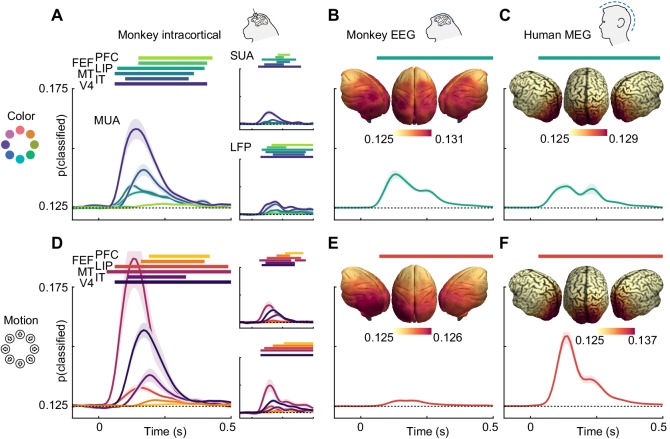
Color and motion direction information across areas and measurement scales.All panels show classifier accuracy, quantified as the single trial prediction probability for the correct stimulus. Error bars indicate standard error over recording sessions (in macaques) or participants (in humans), horizontal lines show periods of significant information (cluster permutation with p<0.05, corrected for number of regions). (A) Color and (D) motion information is available in most areas in multi-unit, single-unit and LFP data. Information decreases along the cortical hierarchy. Note that MUA color information has very similar timecourses in PFC and FEF, and thus, FEF is barely visible. (B) Color and (E) motion information is available in monkey EEG. Insets: distribution of information in monkey EEG, estimated using source-level searchlight decoding. Information peaks in occipital areas. (C) Color and (F) motion information is available in human MEG. Insets: distribution of information in human MEG, estimated using source-level searchlight decoding. Information peaks in occipital areas.